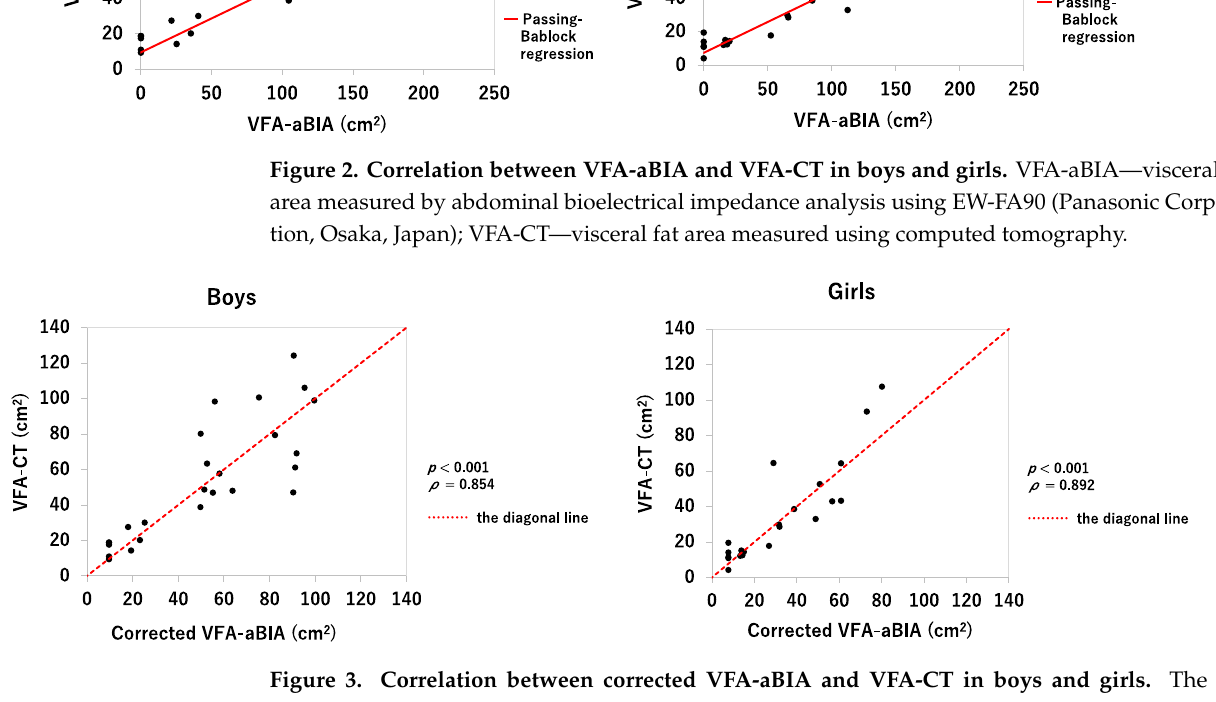
Figure 3. Correlation between corrected VFA-aBIA and VFA-CT in boys and girls. The corrected VFA-aBIA is VFA-aBIA corrected by the Passing–Bablok method: y = 9.600 + 0.3825x (boys) and y = 7.607 + 0.3661x (girls). VFA-aBIA—visceral fat area measured by abdominal bioelectrical impedance analysis using EW-FA90 (Panasonic Corporation, Osaka, Japan); VFA-CT—visceral fat area measured using computed tomography.